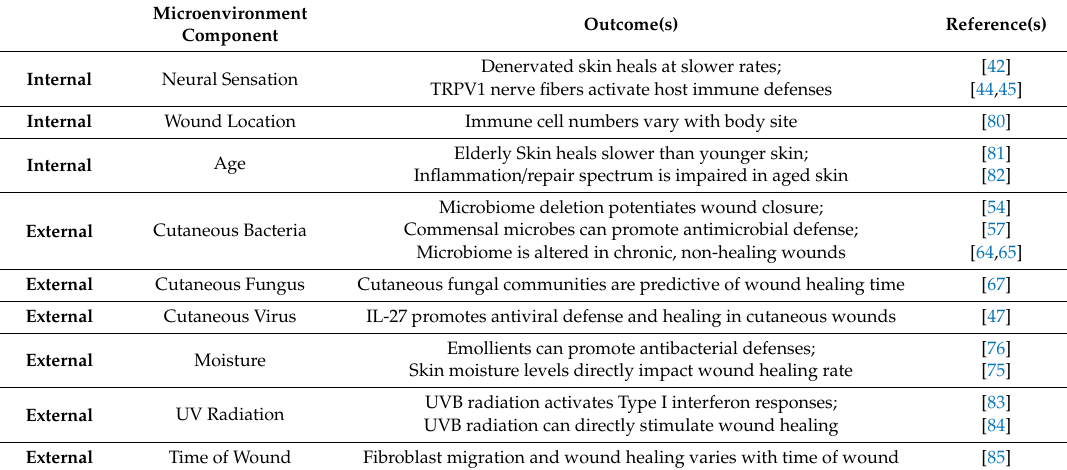
Table 1. Key factors in the innate immune microenvironment that impact